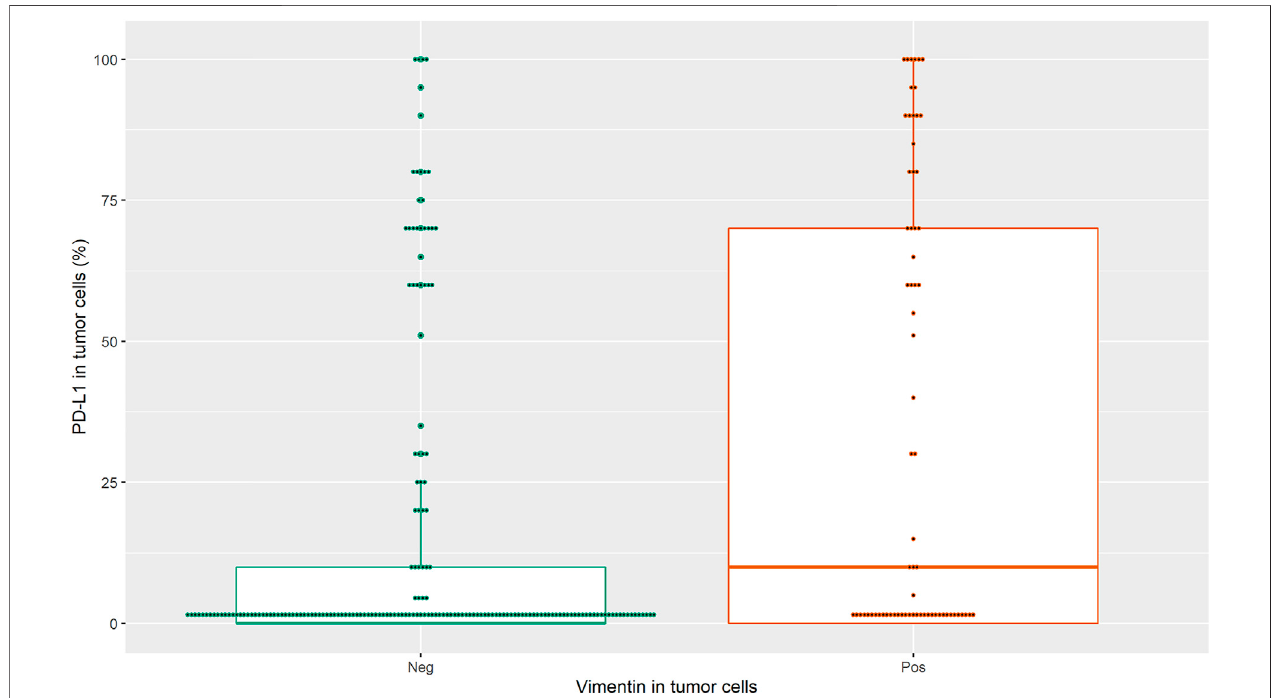
FIGURE 1 | Correlation between the IHC-de fi ned biomarkers i.e. PD-L1 in tumor cells as continuous variable and vimentin in tumor cells as dichotomous variable.